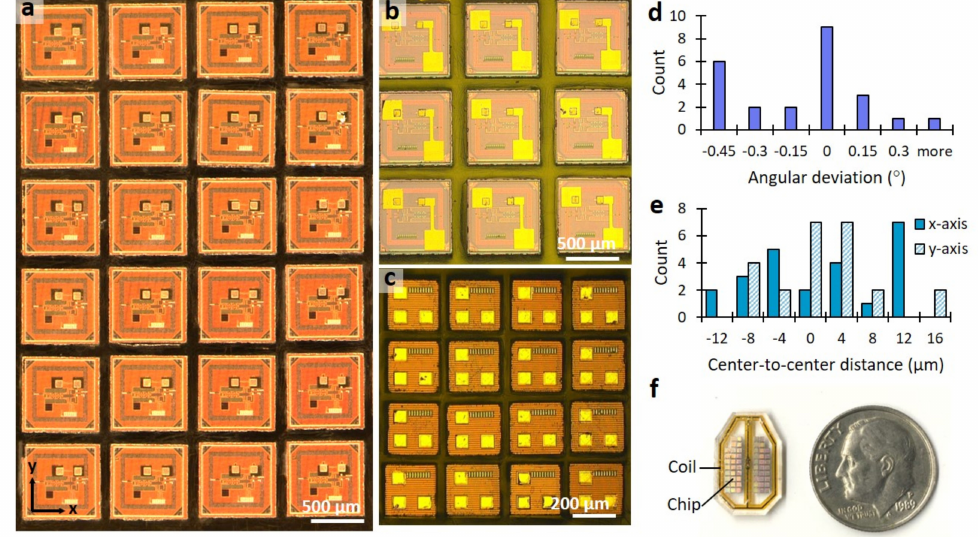
Figure 4. Examples of post-processing multiple CMOS chips through batch fabrication: ( a,b ) the array of 650 µ m × 650 µ m chips with 100 µ m or 200 µ m square Au patterns on two Al-pads within each chip; ( c ) the array of 280 µ m × 280 µ m chips with 70 µ m square Au patterns on three Al-pads within each chip; ( d,e ) histogram of the measured angular orientation and center-to-center lateral distance; ( f ) size comparison with a dime and arrays of 56 chips within a polyimide RF antenna